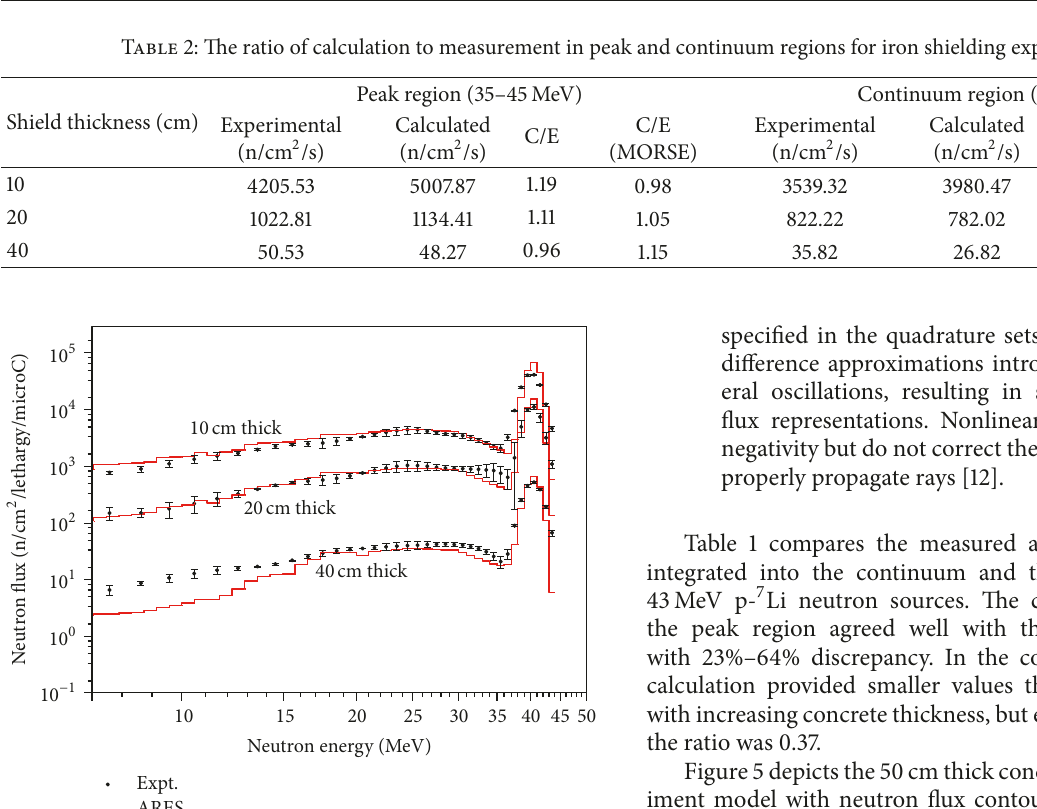
Figure 4: Measured and calculated neutron spectra of the iron